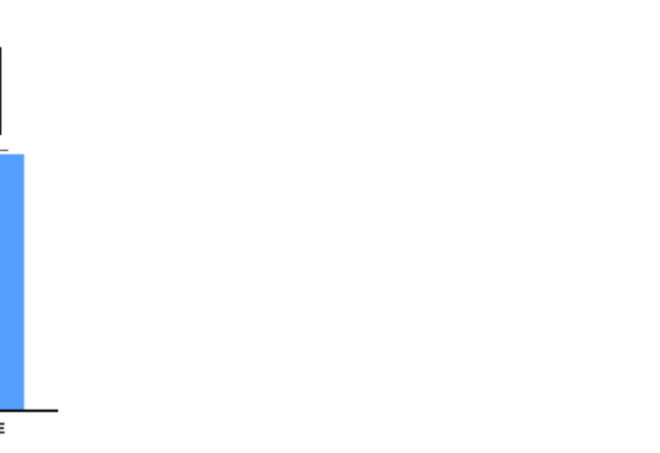
Figure 6. The influence of active polyethylene film on bacteriophage titer. K—PE film; aPE—PE film containing a mixture of CO 2 extracts of raspberry seeds, pomegranate seeds, and rosemary in polymer matrix. unpaired t -test: ****— p < 0.0001.